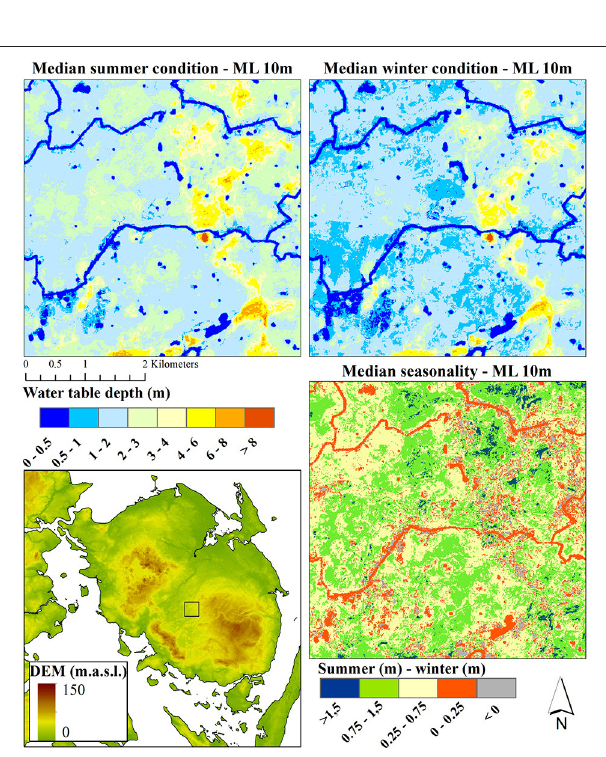
FIGURE 5 | Same data as presented in Figure 4 , but zoomed to an ∼ 15 km 2 area located on the island of Fyn. The zoom location is indicated in the overview map (bottom